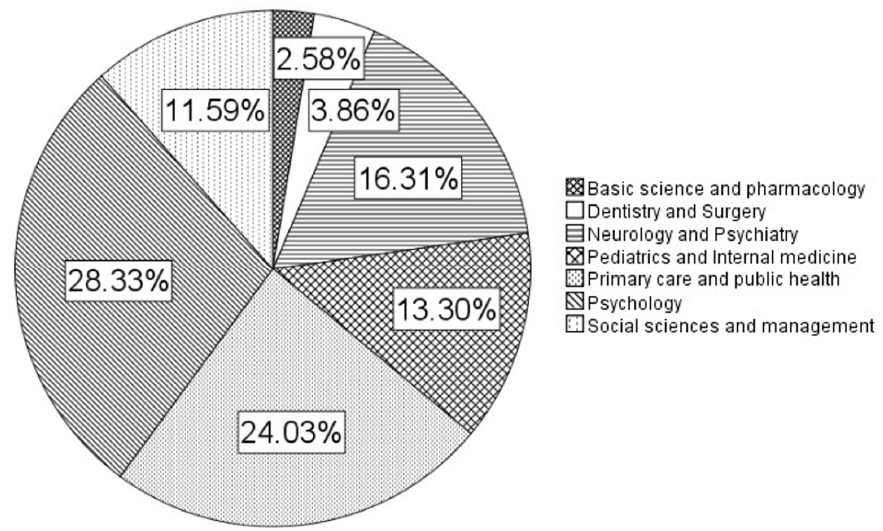
Figure 2. Representation of disciplinary groups and authorship patterns. All included articles were assigned to specific (bio)medical disciplines based on disciplinary affiliation of authors and MESH classifiers.